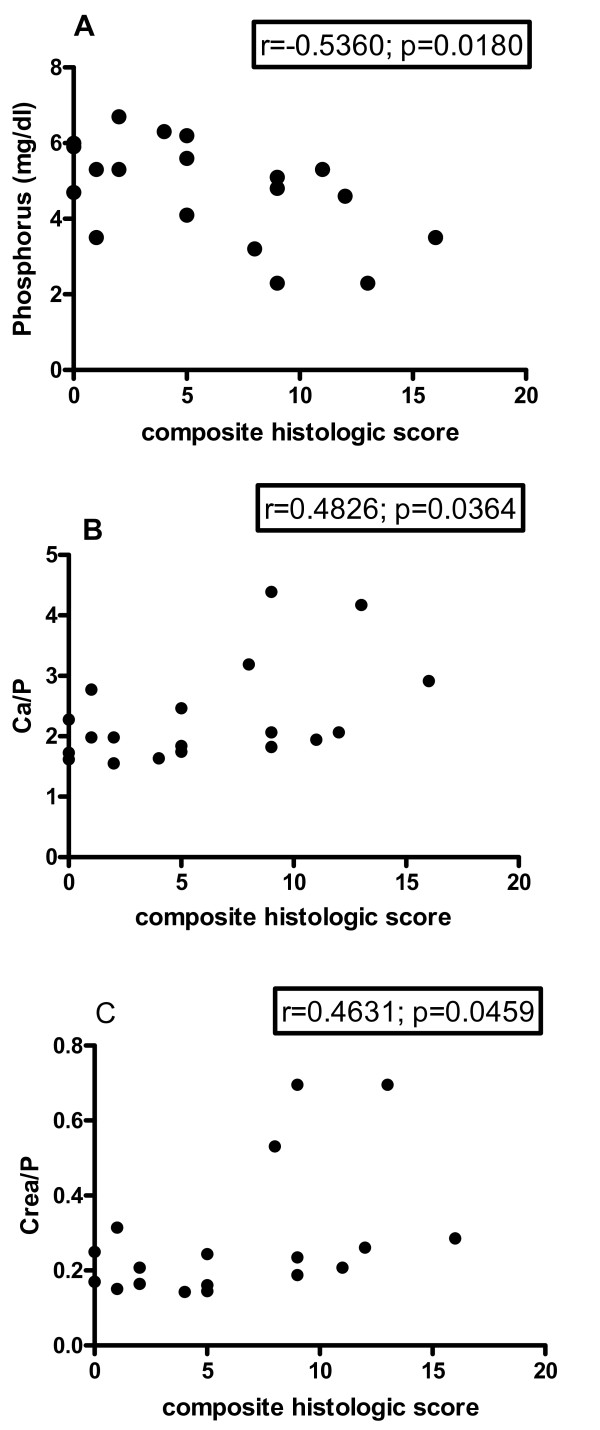
Correlation of serum phosphorus level, Ca/P ratio and Crea/P ratio at the end of ART with severity of nephropathy. Correlation between composite histology score (see criteria in Table 3) and phosphorus (A)/Ca-P ratio (B)/Crea-P ratio (C). A composite ART nephropathy score was generated through the addition of individual tubular pathology values (see Table 3). The p values for the individual correlations are shown next to the slope "r".